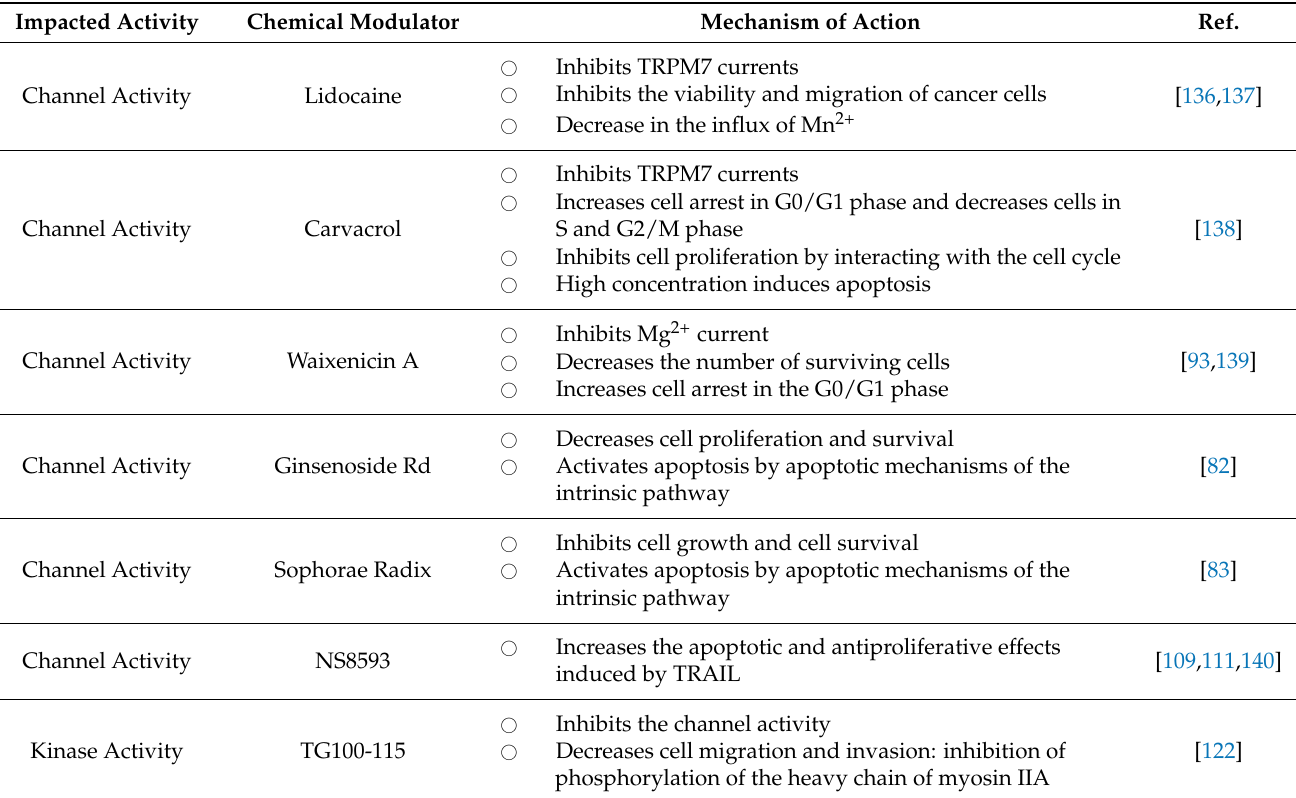
Table 2. Chemical modulators of TRPM7 channel activities as potential anticancer